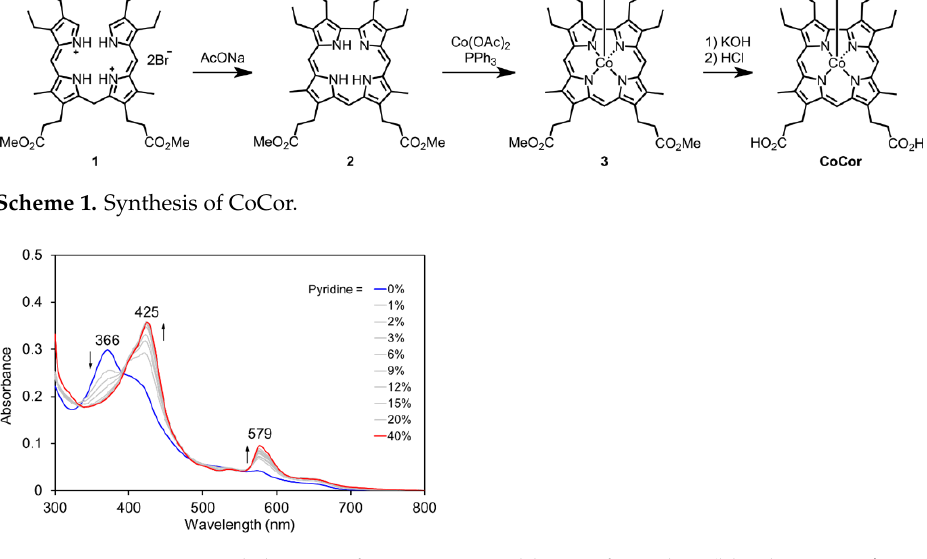
Figure 2. UV-vis spectral changes of CoCor upon addition of pyridine (blue line: 0% v/v , red line: 40% v/v ). [CoCor] = 5 µ M in MeOH containing 1–40% v/v pyridine at 25 ◦